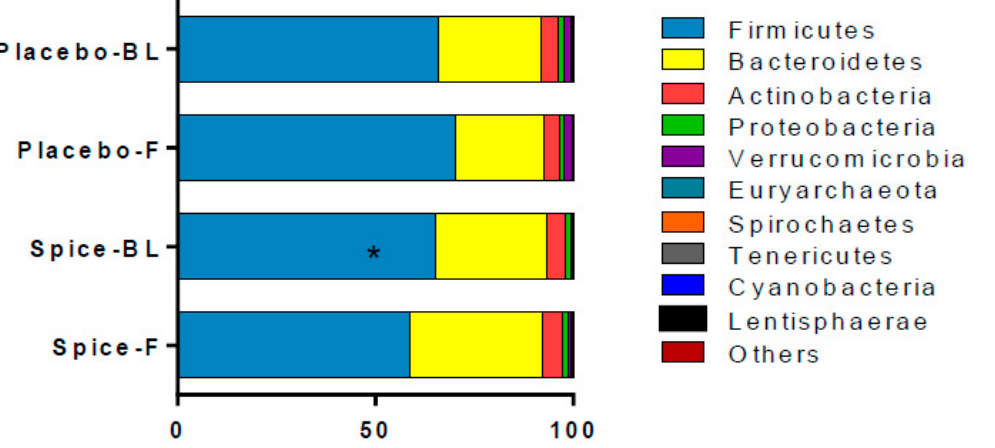
Figure 4. Comparison of fecal microbiota in subjects supplemented with placebo and mixed spices capsules. Bar graph shows the relative abundance of phylum in subjects supplemented with placebo ( n = 15) or mixed spices ( n = 14) at baseline and after 2 week intervention. Each color within the bar graphs represents a phylum, with area of the color proportional to relative abundance. PBL, placebo group at baseline; PF, placebo group at follow up; SBL, spice group at baseline; SF, spice group at follow up. Data are means ± standard errors (SE). Significant difference in abundance between placebo and spice group is indicated by * p < 0.05.